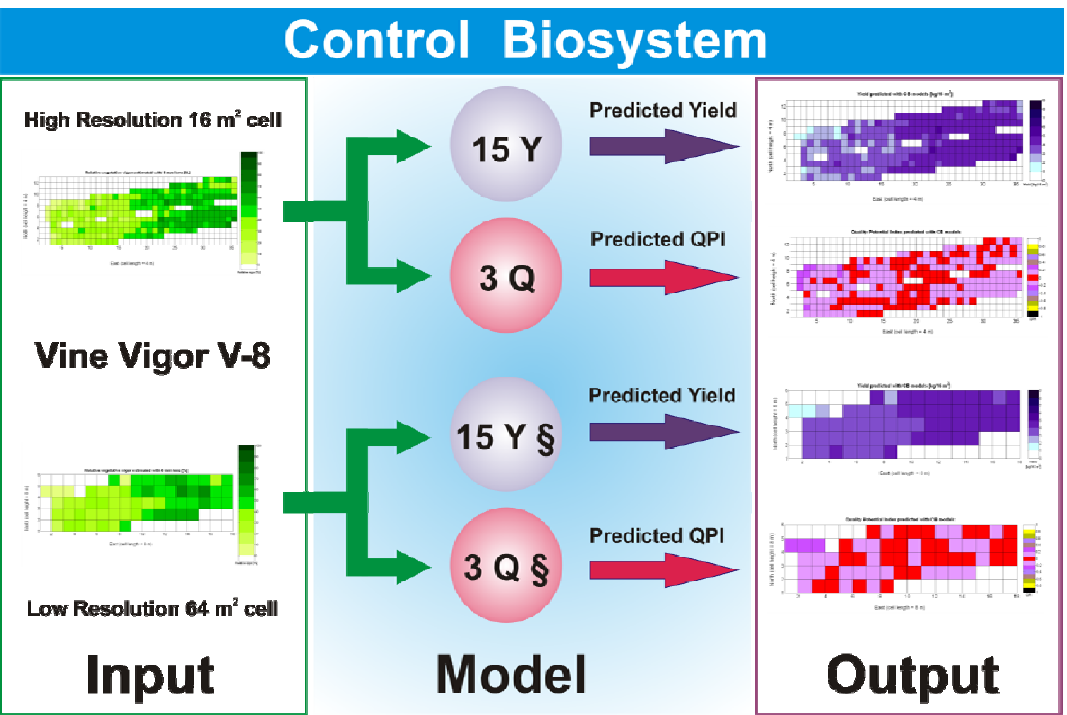
Figure 33. Concept of Control Biosystems for vineyards based on Crop Biometric